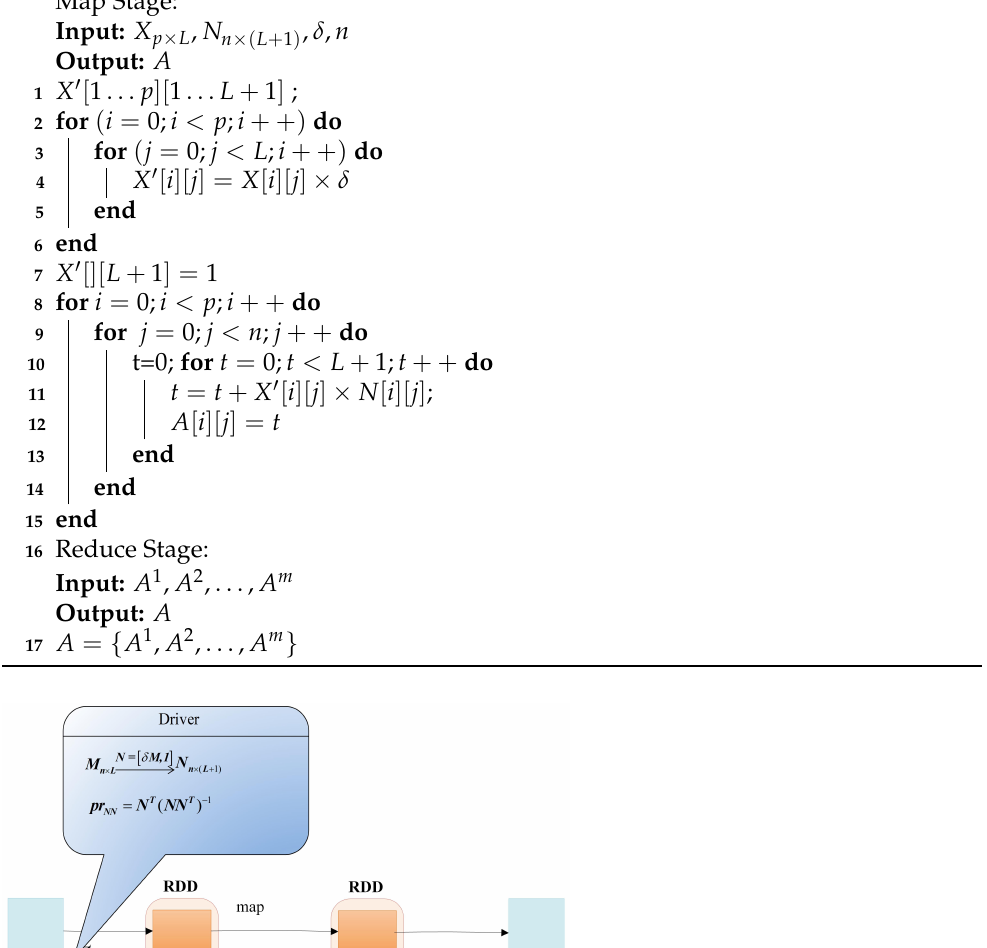
Algorithm 2: Parallel Sum-to-one Least Squares abundance inversion on Spark.